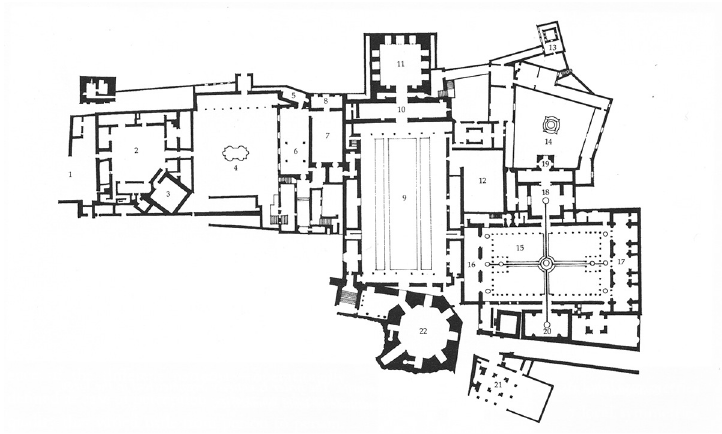
Figure 10. Plan of the Alhambra. Source: { Nature of Order Book One}